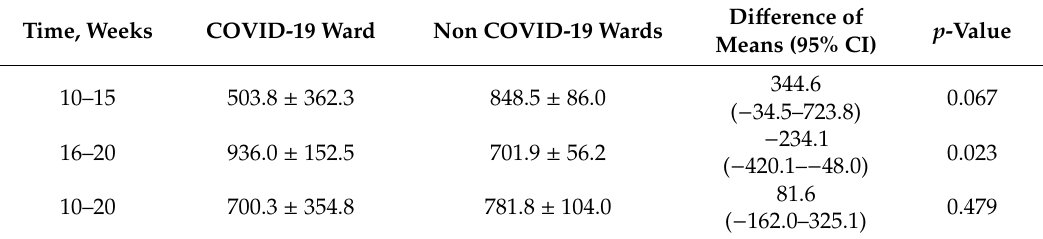
Table 1. Antimicrobial consumption for the COVID-19 ward and the hospital without the COVID-19 ward during the pandemic period (weeks 10–20).